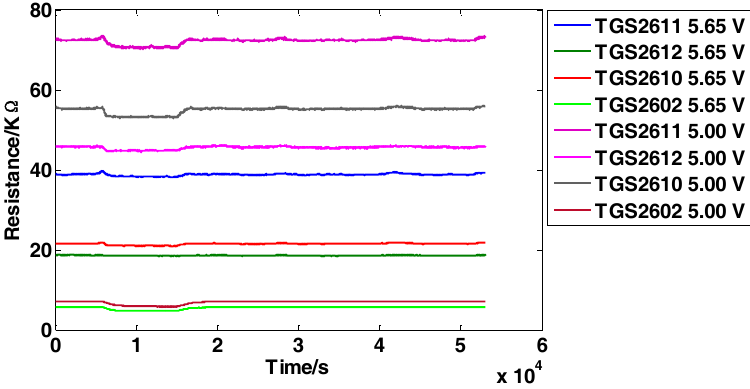
Figure 2. Response curves of the sensors on carbon monoxide with the concentration of 25 ppm.